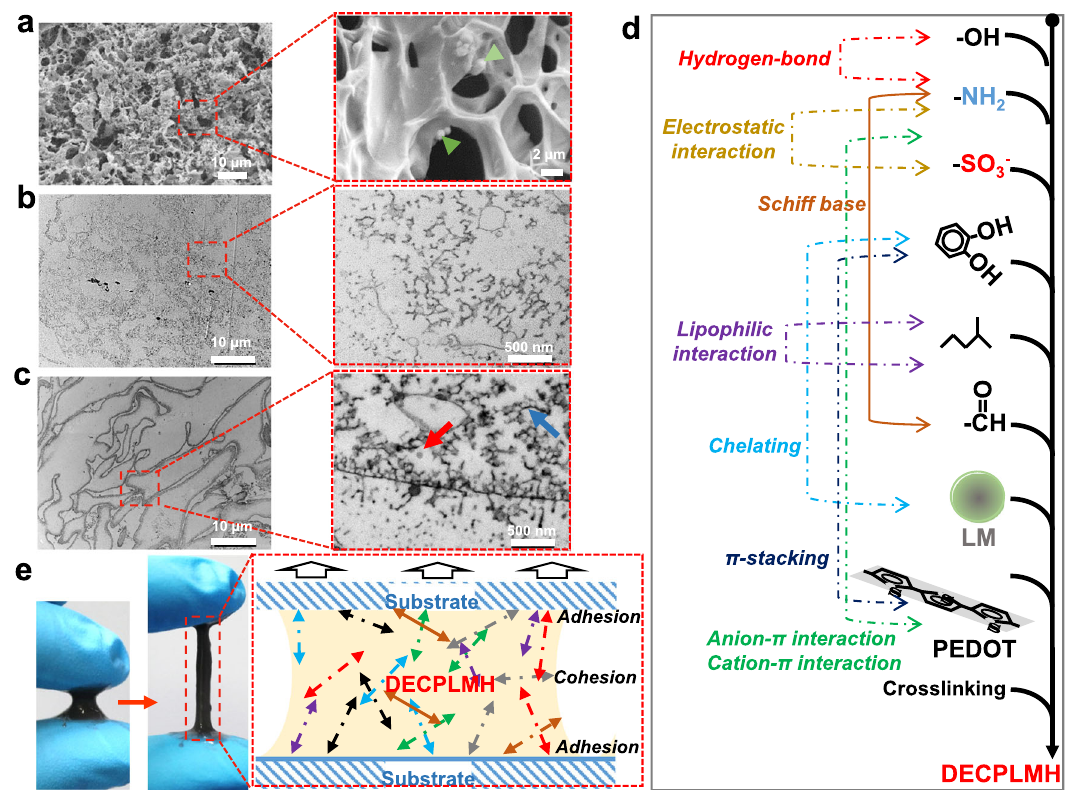
Fig. 3 Illustration of multiple types of reversible chemical bonds that could be important for the development of potent bioadhesives. a Cryo-SEM images of DECPLMH networks. The arrows in samples indicate LM nanodroplets in the DECPLMH networks. A representative image of three samples is shown. b Transmission electron microscope (TEM) image of DECPH networks. A representative image of three individual experiments is shown. c TEM image of DECPLMH networks. The arrows in samples indicate LM nanodroplets in the DECPLMH networks. A representative image of three individual experiments is shown. d Schematic illustration of multiple types of interactions, which contribute to form the dynamic electroconductive biopolymer/liquid metal hydrogels (DECPLMH). e Photos of DECPLMH are sketched with two fi ngers and schematic illustration of multiple types of interactions, which contribute to the cohesion and adhesion property of the